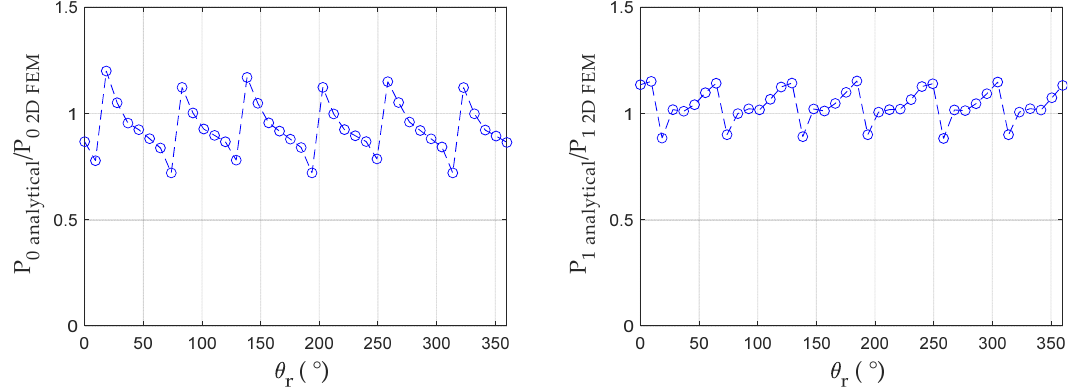
Figure 13. Comparission between analytical and FEM airgap permeances 𝒫 (cid:2868) and 𝒫 (cid:2869) .